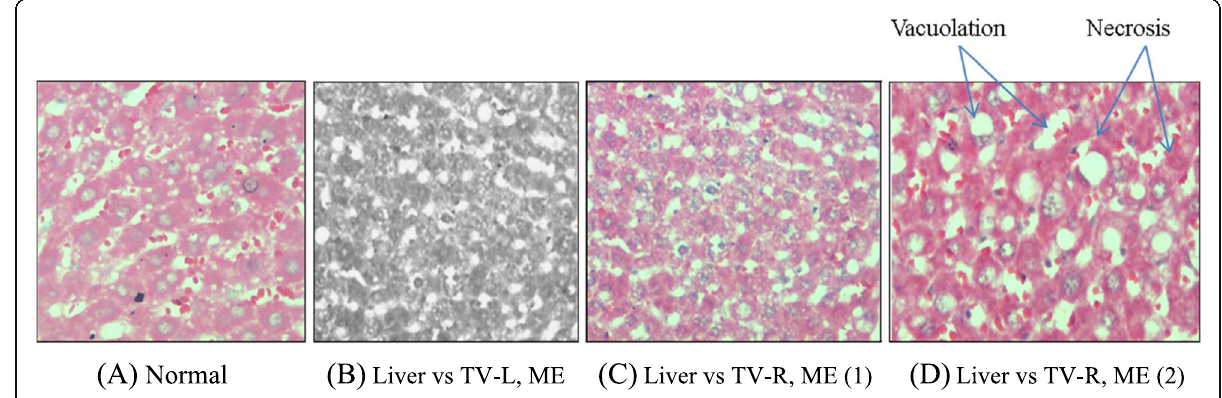
Fig. 2 Histopathological slides of Liver sections at day 14 (H&E stained under 20x magnification power) where the slide ( a ) represent control (normal) ( b ) represent liver tissues treated with TV-L, ME at doses of 600, 1200 and 2000 mg/kg ( c ) represent liver tissues treated with TV-R, ME at doses of 600 and 1200 mg/kg) ( d ) represent liver treated with TV-R, ME at doses of 2000 mg/kg body